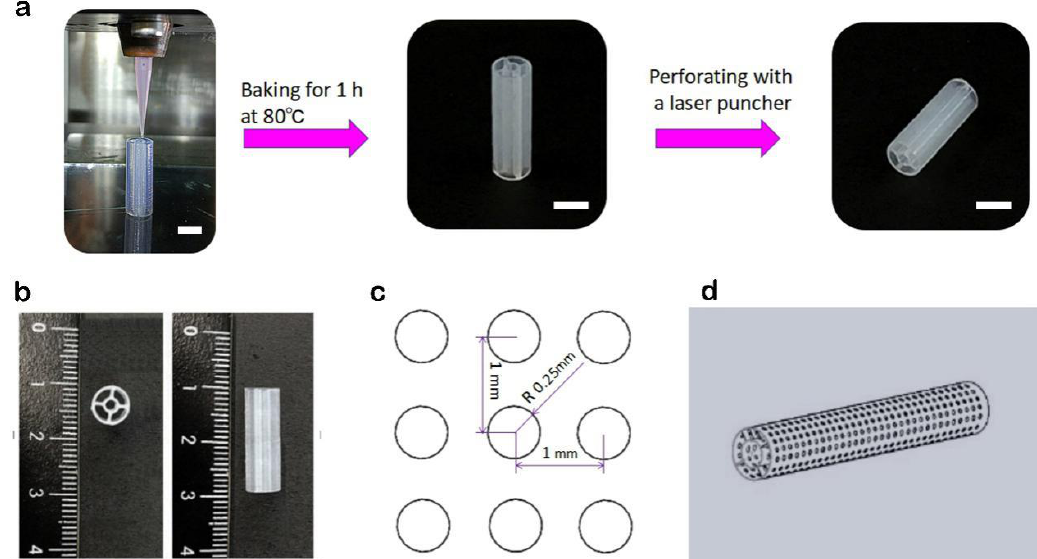
Figure 8. Construction processes of the supporting structure. ( a ) 3D bioprinting according to a CAD (computer-aided design) model, baking, molding, and laser drilling. (Scale bar: 5 mm). ( b ) Inner and outer cylindrical supporting structure. ( c ) Size and spacing of laser drilling. ( d ) A pattern diagram of the supporting structure with micropores.